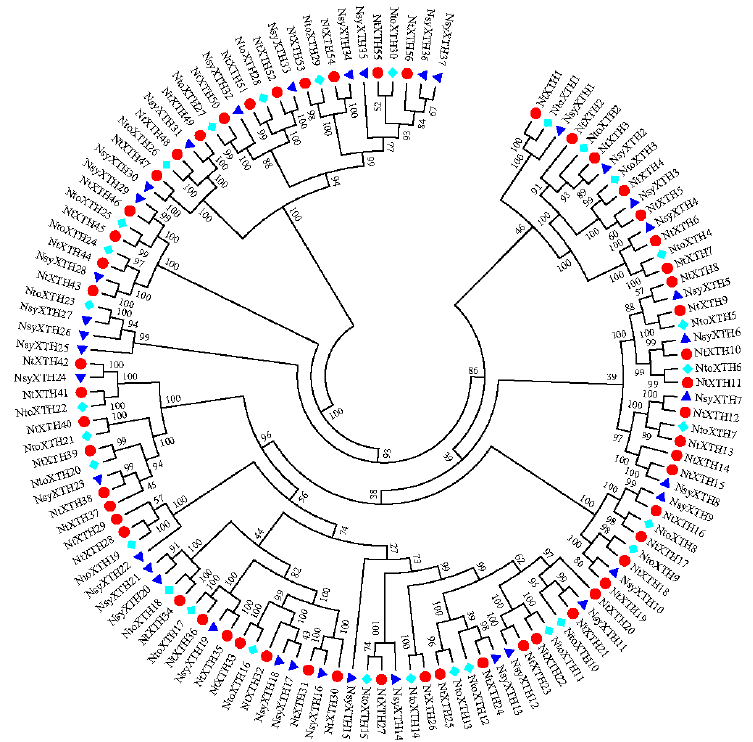
Figure 3. Neighbor-Joining phylogenetic tree of full-length XTH proteins in N. tabacum (red circle), Nicotiana sylvestris (dark blue triangle) and Nicotiana tomentosiformis (light blue diamond).